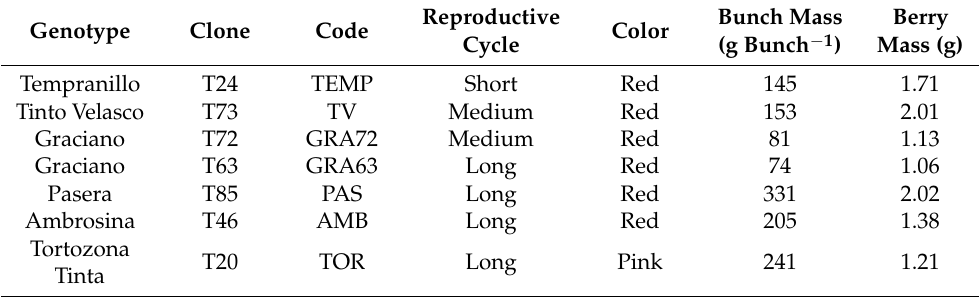
Table 5. Summary of the characteristics of the genotypes from seven local old grapevine varieties used in this study. Data provided by the Estaci ó n de Viticultura y Enolog í a de Navarra (EVENA) (Navarra, Spain) were collected in 2019 from plants grown in the vineyard.